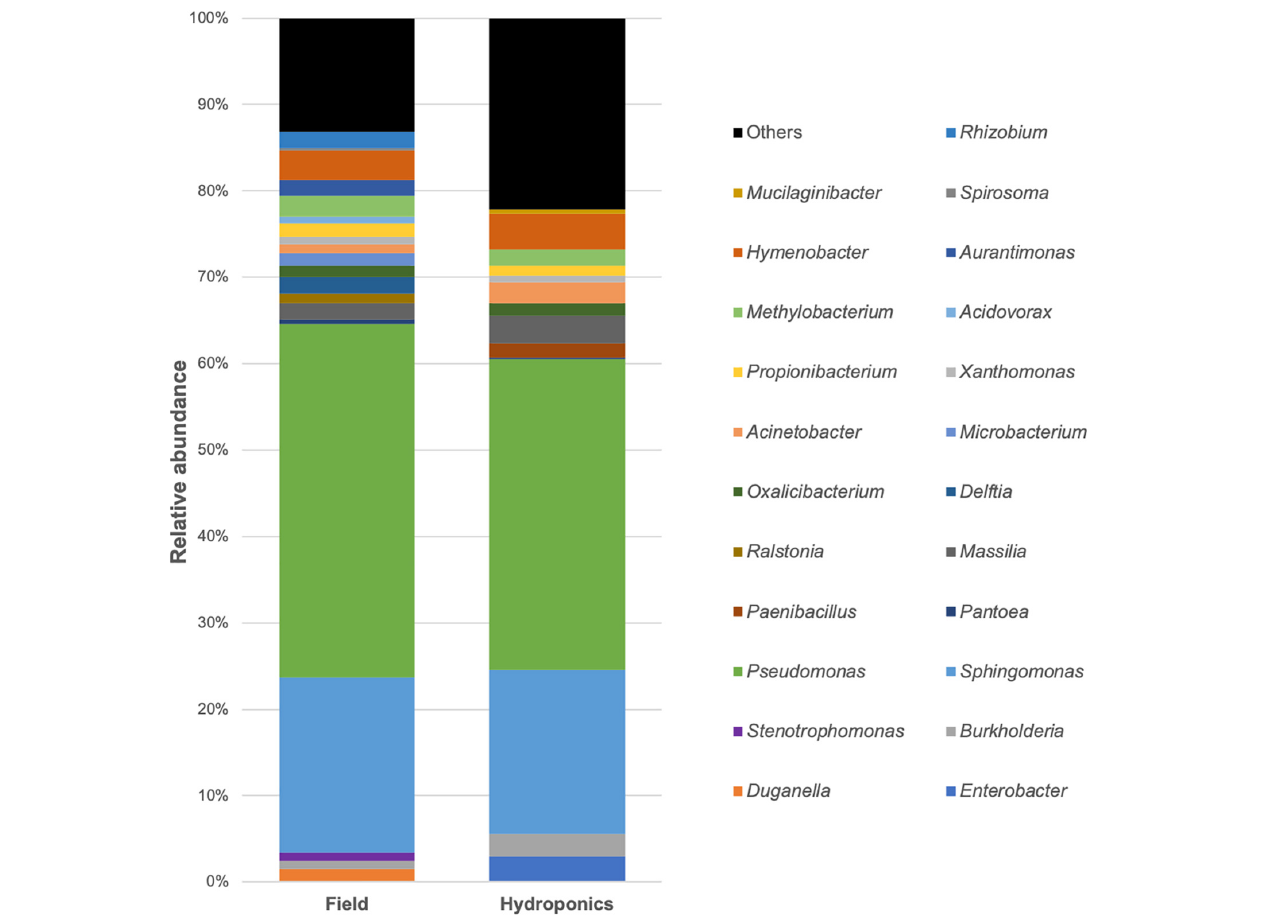
FIGURE 3 | Relative sequence abundance of bacterial genera associated with field and hydroponics-grown plants. The most represented operational taxonomic units (OTUs), with relative abundance higher than 1%, are reported. OTUs with less than 1% are assigned as “Others.”